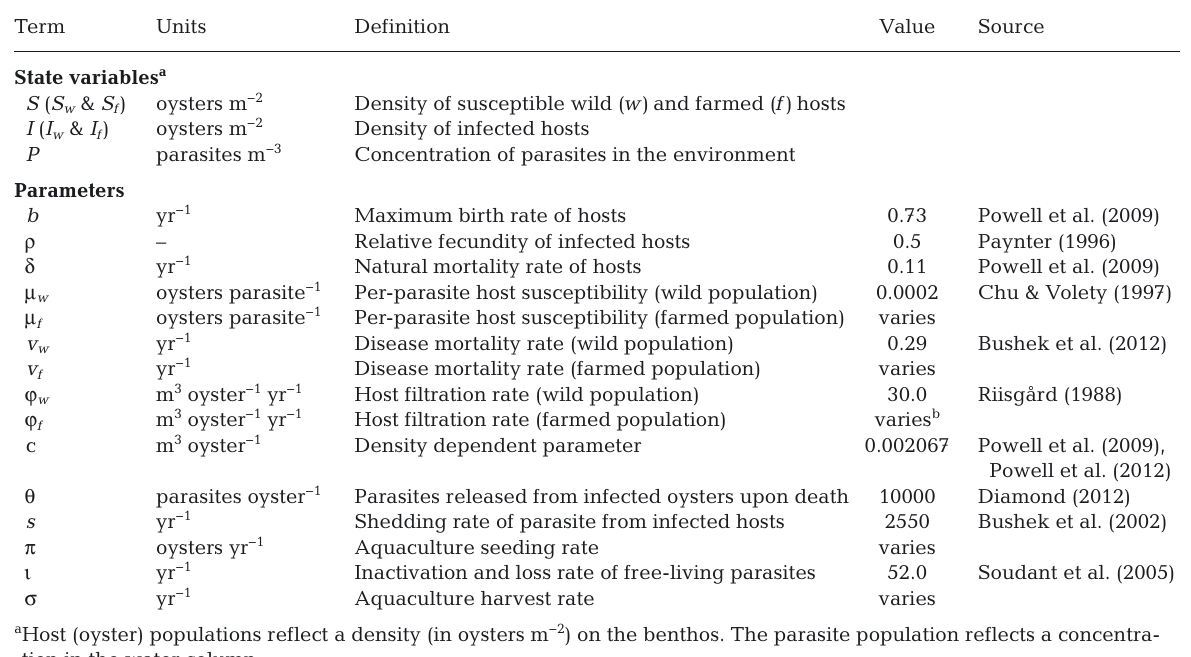
Table 1. State variables and parameters used in the epidemiological